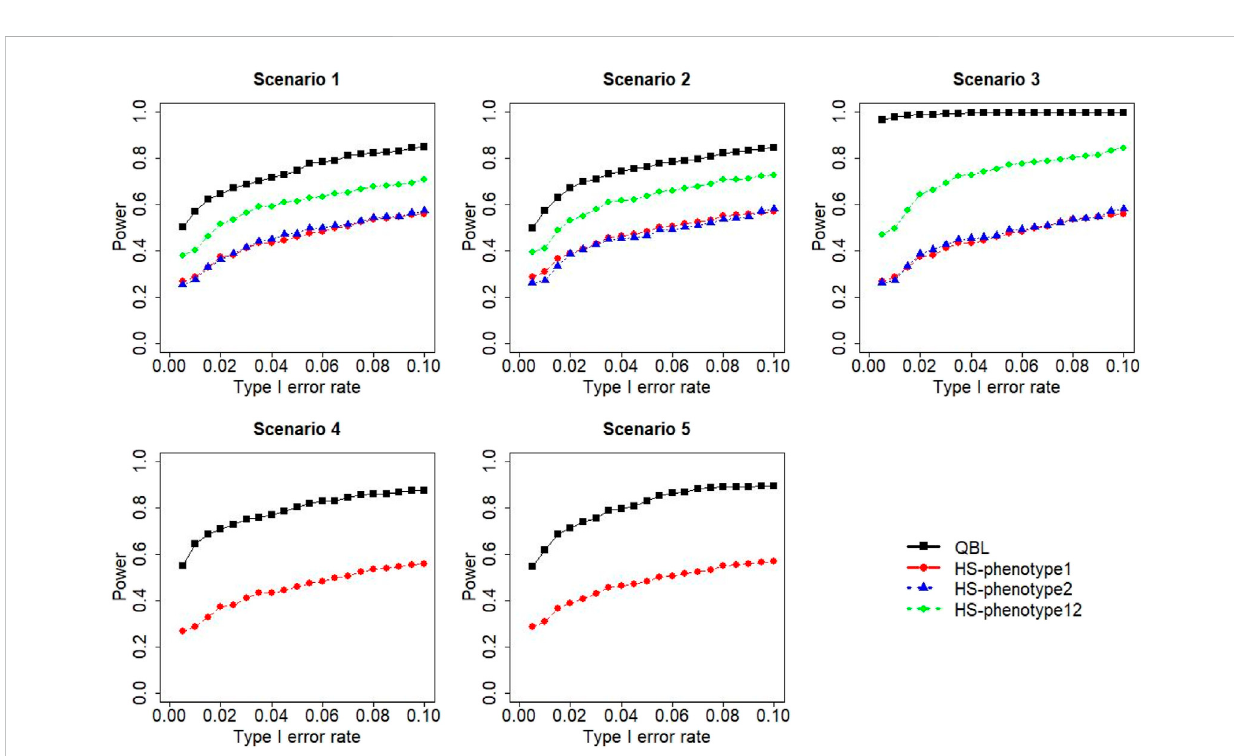
FIGURE 2 Simulation results under sample size 500, setting 1 (six haplotypes), and ρ = 0.5. Scenarios are shown in Table 1. HS, Haplo.score; phenotype12, phenotype 1 or